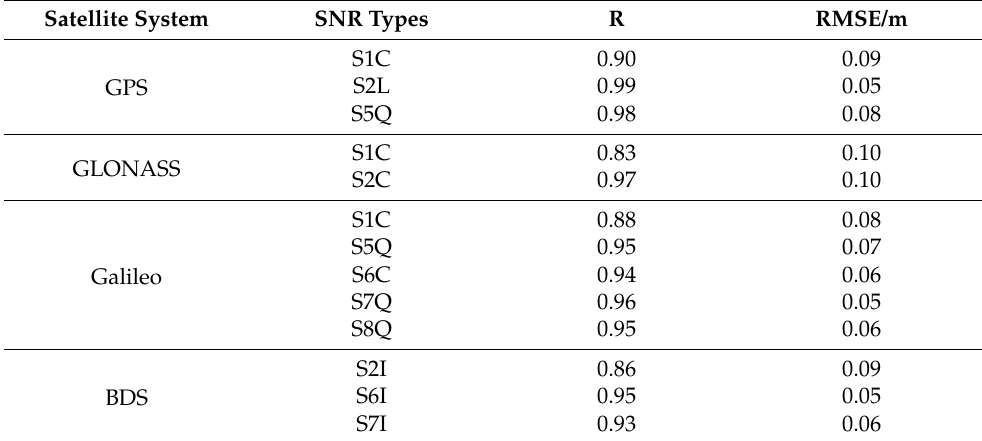
Table 3. R and RMSE between multi-GNSS and multi-frequency GNSS-IR snow depth retrieval results and PBO snow